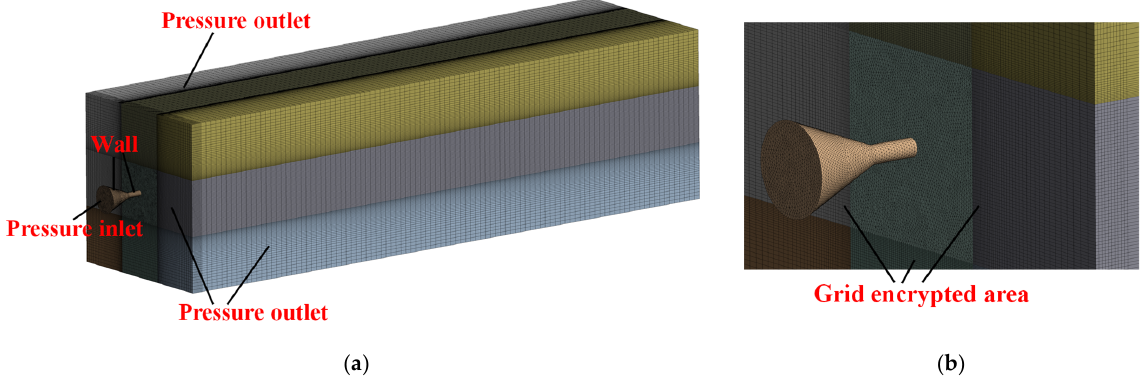
Figure 9. Computational model of nozzle and flow field: ( a ) boundary conditions; ( b ) local zoom.